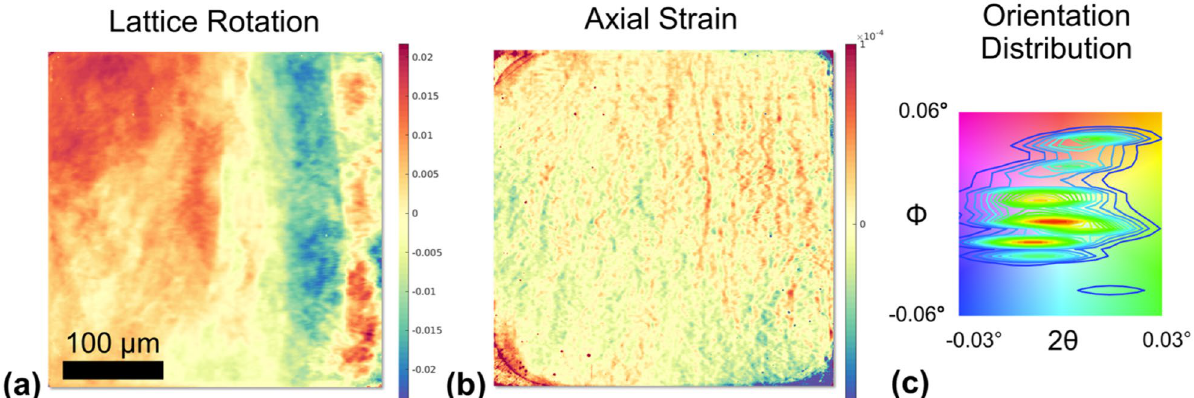
Figure 6. Computed COM maps of φ rotation (i.e. rocking curve COM map) (a) and relative axial strain (b) of (002) reflection. The color key shows the φ − 2 θ angular distribution in the scanned range around the local intensity maxima for the respective axes (c) . These maps show the projections from a volume illuminated by 2 box-shaped beam having a size of 400 × 400 µ m , rather than a line focused beam (See Supp. Mat. for more 4 details). The measured strain is rather homogeneous having values below 10 − , in spite of the clear boundaries that are visible in the φ COM map. The figure is made using the MATLAB code in the link https:// github. com/ leora dm/ Dislo catio n3DAn alysis. git and https:// gitlab. esrf. fr/ julia. garri ga/